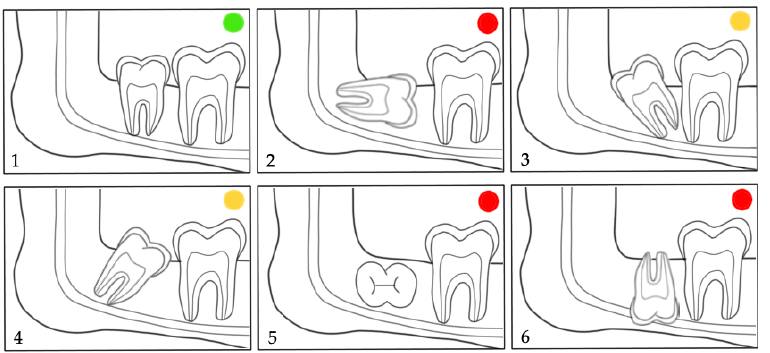
Figure 4. Winter’s classification for the inclination of the mandibular M3 relative to the longitudinal Figure 3. Archer’s (vertical) classification for the impaction depth of the maxillary M3 relative to the axis of M2 [24]. Subdivisions according to the eruption prognosis of M3 in 1 : good ( ); 3 , 4 : ques ‐ adjacent M2 [23]. Subdivisions according to the eruption prognosis of M3 in 1 , 2 : good ( ); 3 – 5 : bad tionable ( ); 2 , 5 , 6 : bad prognosis ( ). prognosis ( ).